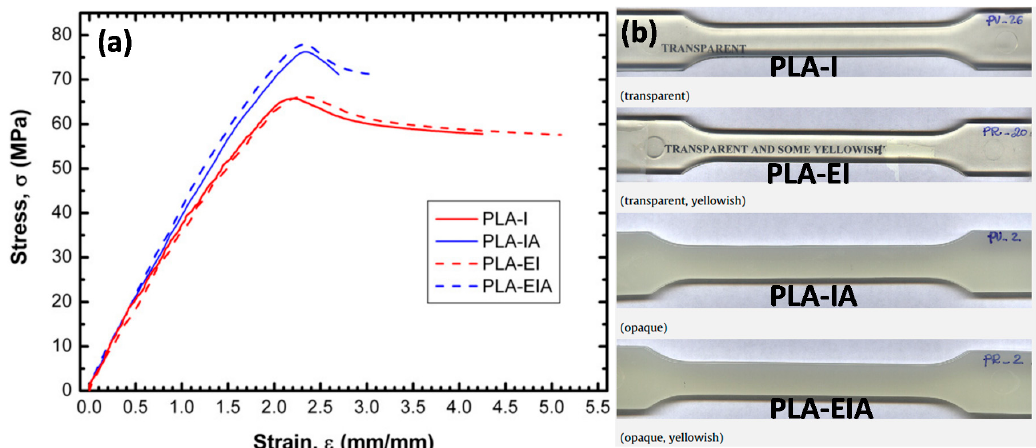
Figure 5. ( a ) Representative stress vs. strain curves from tensile testing for processed PLA polymers.